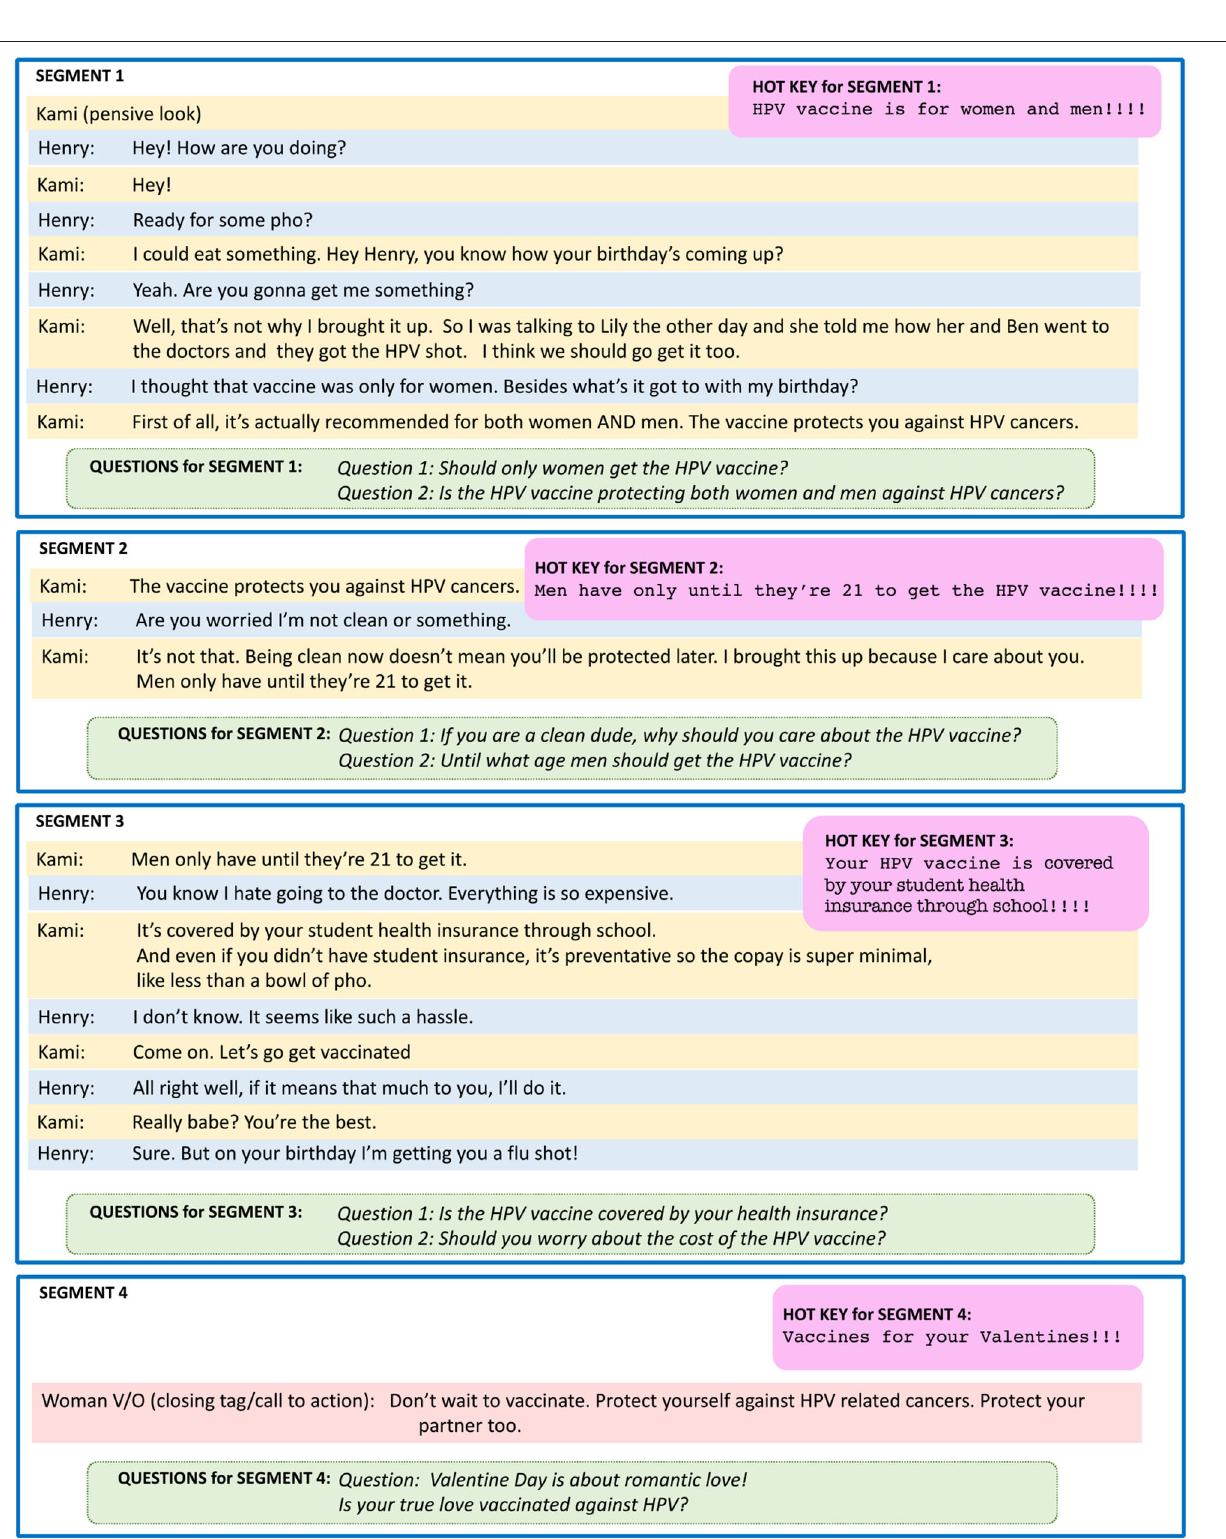
Frontiers in Digital Health |